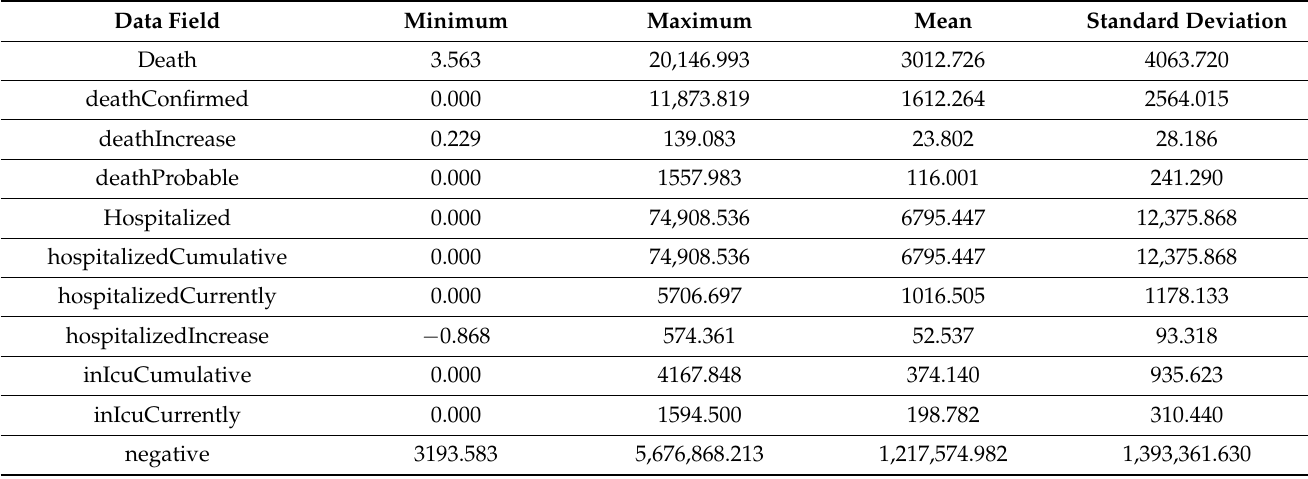
Table 3. Dataset descriptive statistics.